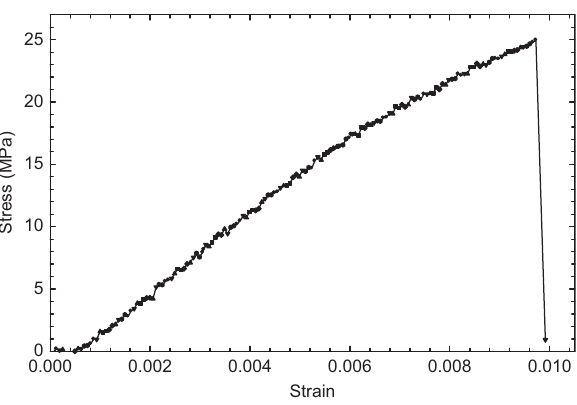
Figure 8 Experimental stress-strain diagram for specimen material using TPB.